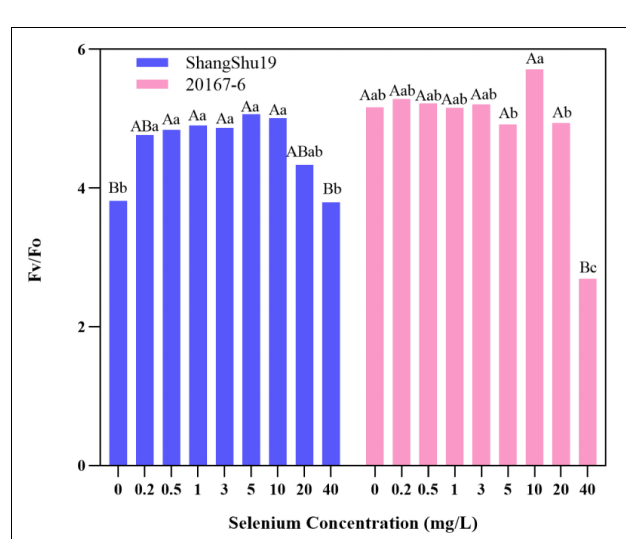
FIGURE 8 | Effects of different selenium concentrations on potential activity (Fv/Fo) of PSII after dark treatment of sweet potato. Different lowercase letters in the same category indicated that there were significant differences between Se treatments (Sig < 0.05); Different capital letters in the same category indicated that there were significant differences between Se treatments (Sig <